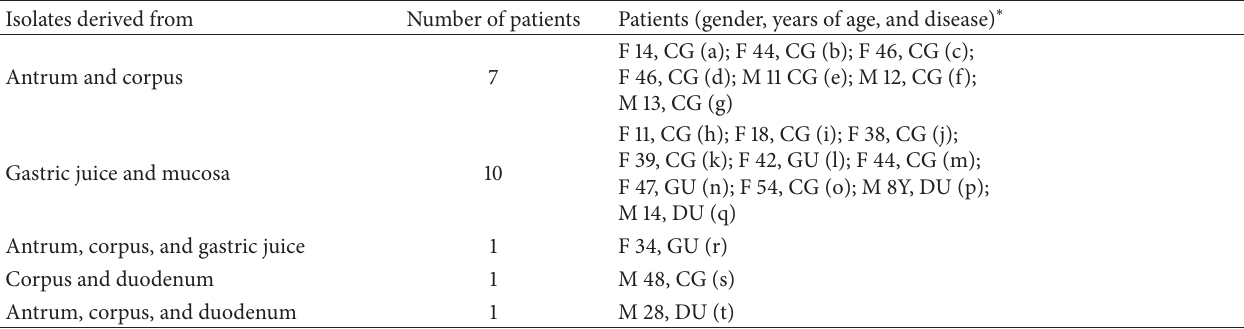
Table 1: Characteristics of patients from whom plural isolates, which were thought to be originated from the same clone, were obtained from different specimens.